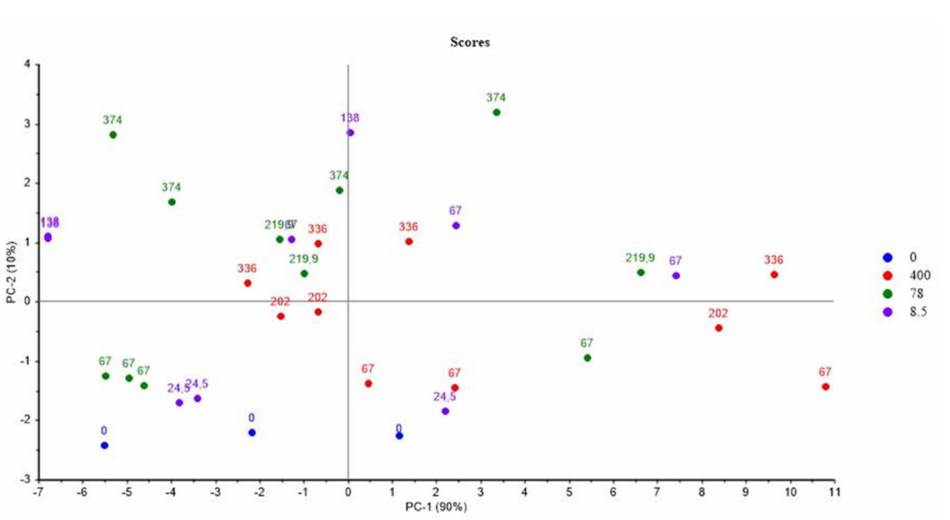
Figure 1. PCA results on Mod1: UJV irradiation dose rate (Gy/h) with doses (kGy) and irradiation